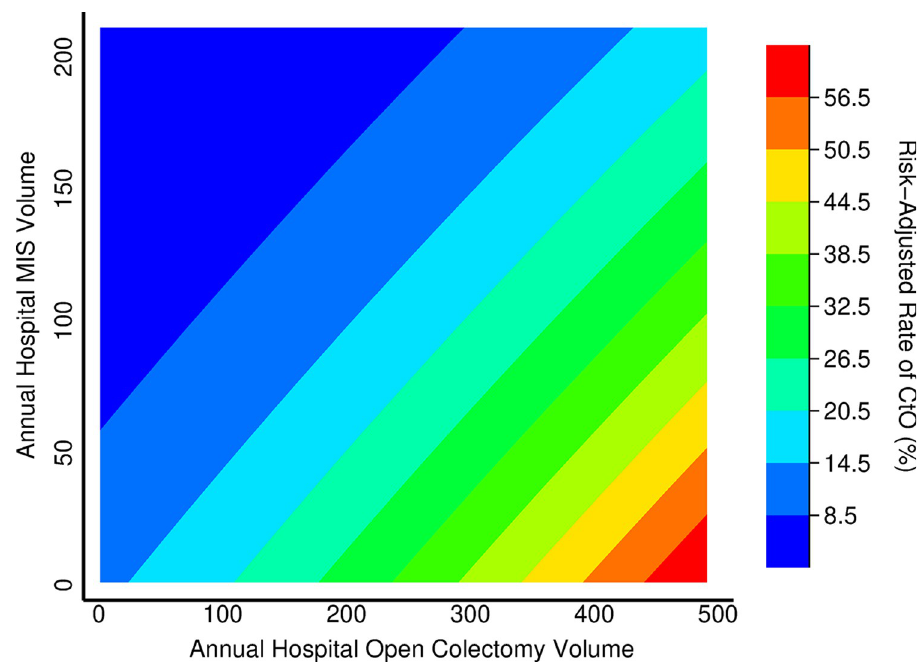
Fig 4. Contour plot of relationship between conversion to open (CtO) and annual hospital volume of minimally invasive surgery (MIS) and open colectomy.